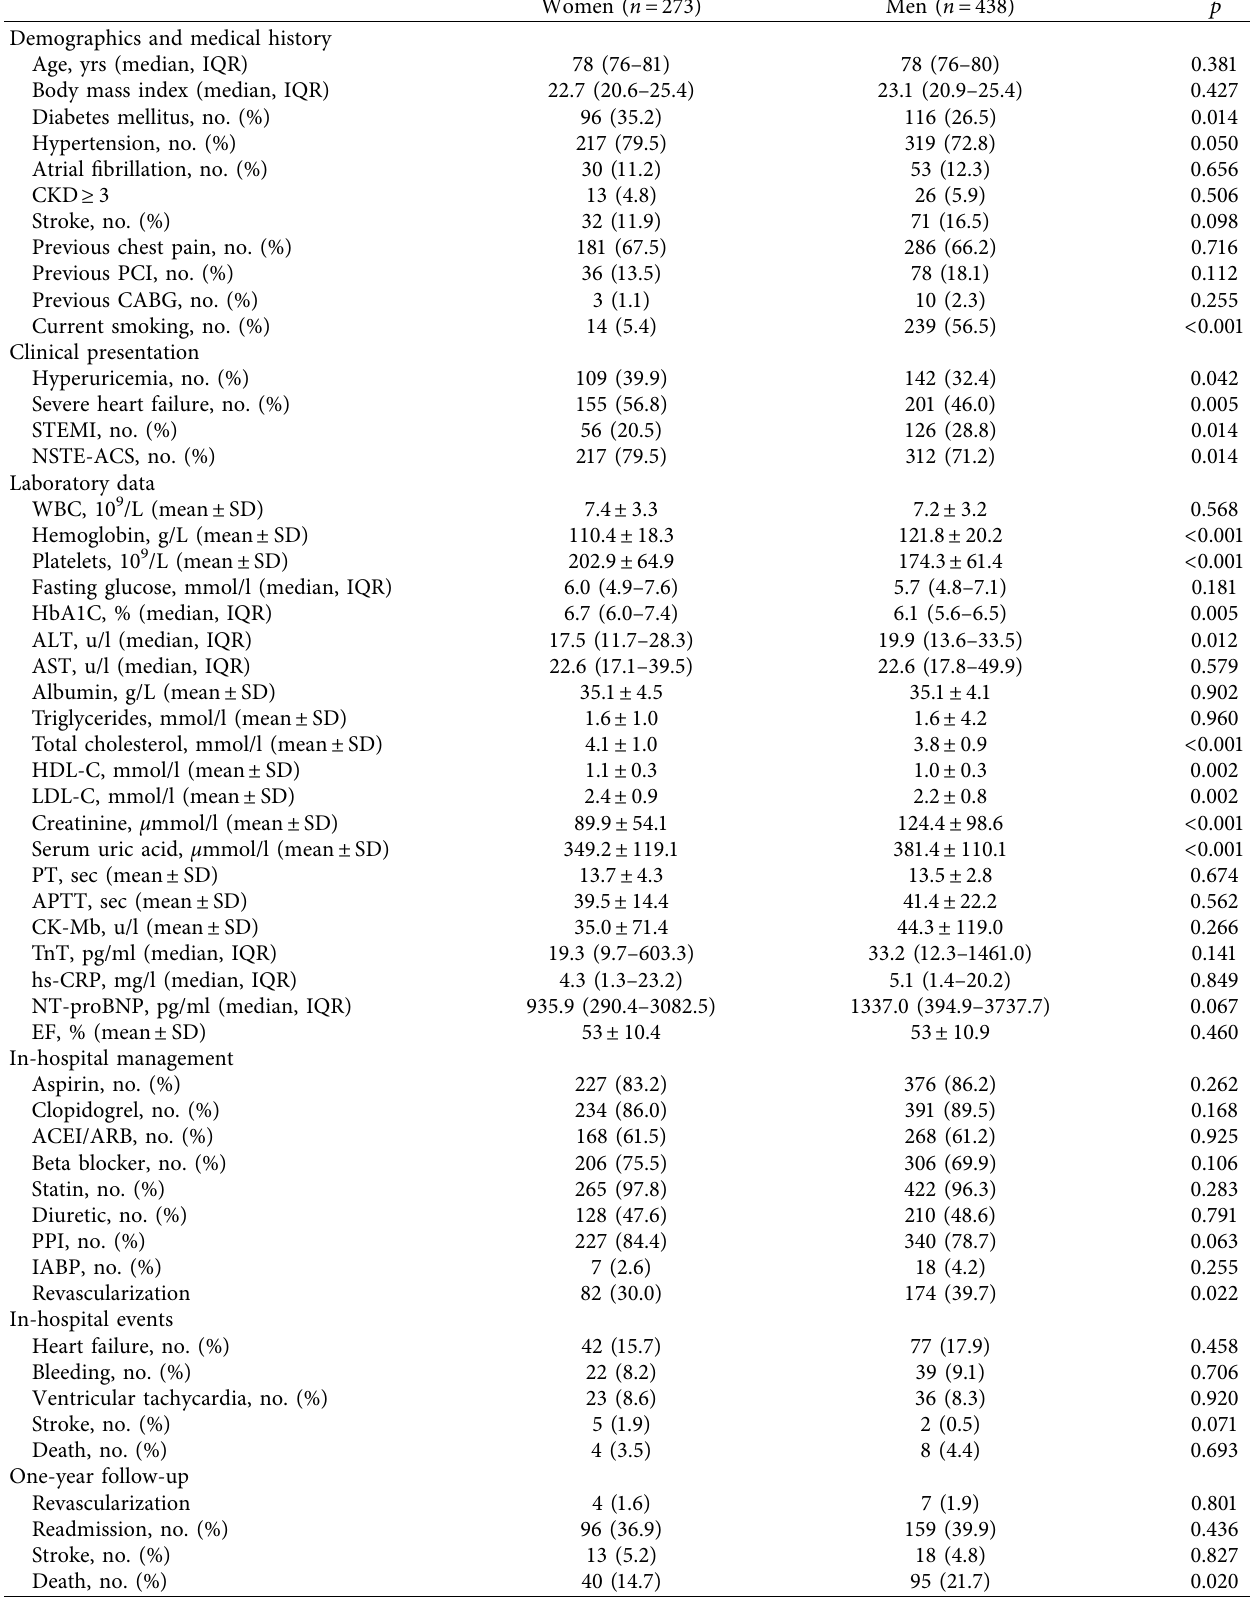
Table 1: Differences between women and